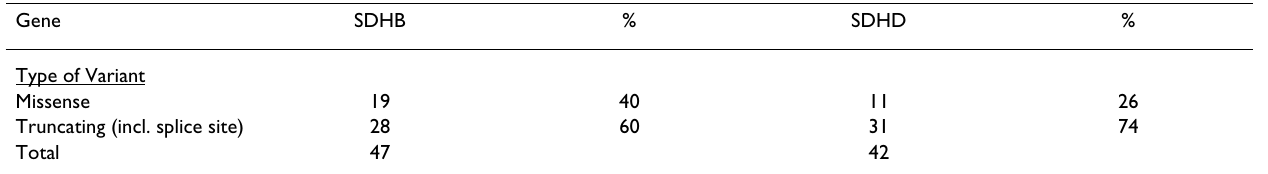
Table 2: Differing frequencies of missense mutations vs. truncating mutations (nonsense, frameshift, splice site and major deletions) in SDHB and SDHD. Gene SDHB %